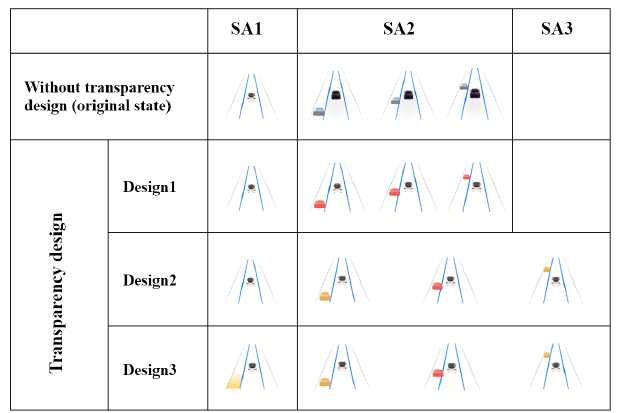
Figure 3. The original state of interface and three design schemes. The original interface can only show the change in distance between the rear vehicle and the ego vehicle; Design1 shows a change in distance and a red danger indication; Design2 shows the change of distance and the change of color indicating the danger level; Design3 provides a forewarning of the rear vehicle based on Design2.